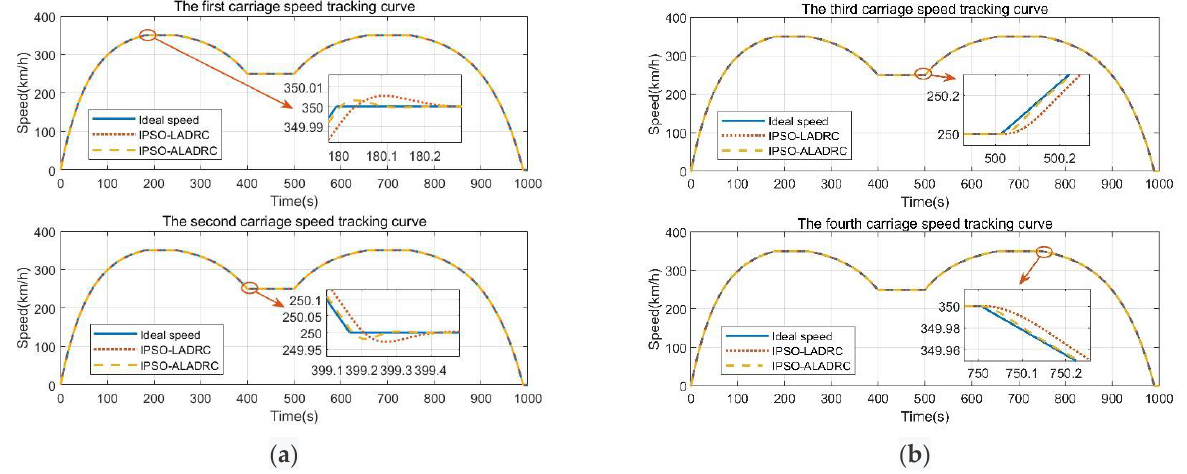
Figure 7. Speed tracking curve of the four carriages: ( a ) Speed tracking curve of the first two carriages; ( b ) Speed tracking curve of the last two carriages.